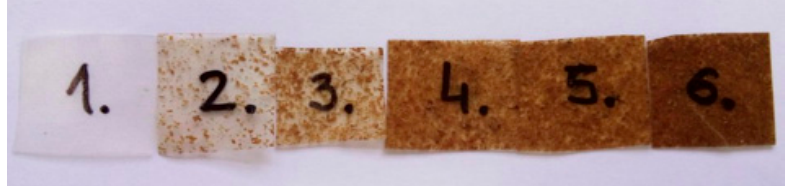
Figure 1. Digital photographic images of (1) neat LDPE, (2) LDPE + 10 wt % RH, (3) LDPE + 20 wt